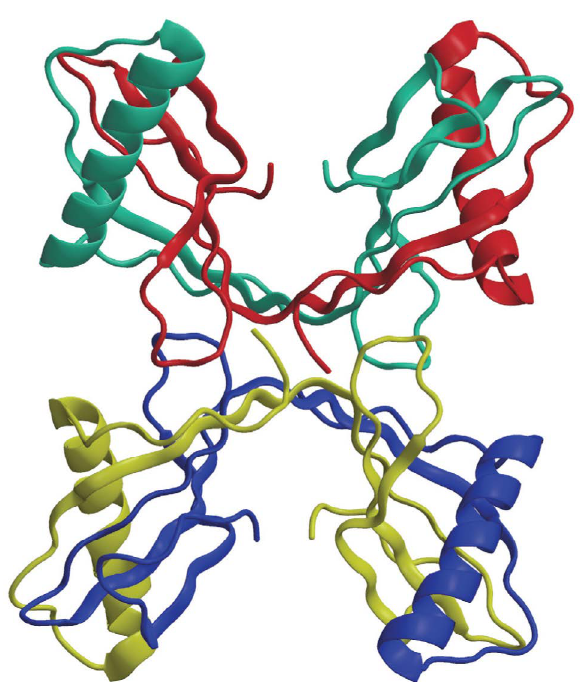
Figure 6. Stefin A tetramer 150 (2OCT). Each chain in the tetramer is shown as ribbon with own color. The dimers of the two domain swapped dimers are shown at the top and bottom of the figure. The two dimers interlink with loop handshake shown in the